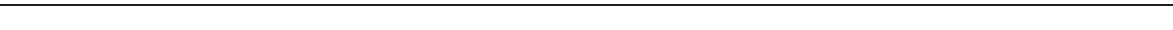
Fig. 5 Vascular alterations after intraocular VEGF-A injection. a Morphology of IB4-stained P6 wild-type retinal vessels at 4 h after administration of human VEGF-A165 (0.5 µ l at a concentration of 5 μ g μ l − 1 ). Note blunt appearance of the vessel front after VEGF-A injection but not for vehicle (PBS) control. Scale bar, 200 µ m. b Quantitation of sprouts and fi lopodia at the front of the P6 vessel plexus after injection of VEGF-A165 or vehicle control. Error bars, s.e.m. p -values, Student ’ s t -test. c PDGFR β + (green) pericytes are unaffected by short-term VEGF-A administration, whereas VEGFR2 immunosignals (white) are increased in IB4+ (red) ECs (arrowheads). Images shown correspond to insets in a . Scale bar, 100 µ m. d Quantitation of VEGFR2 immunosignals intensity in the peripheral plexus of P6 retinas after injection of VEGF-A165 or vehicle control. Error bars, s.e.m. p -values, Student ’ s t -test. e Confocal images showing increased Esm1 immunostaining (white) in IB4+ (red) ECs in the peripheral plexus (arrowheads) after VEGF-A injection in P6 pups. Scale bar, 200 µ m. f VEGF-A165 injection-mediated increase of Esm1 immunosignals (normalized to IB4+ EC area) in the peripheral capillary plexus but not at the edge of the angiogenic front in comparison to PBS-injected controls at P6. Error bars, s.e.m. p -values, Student ’ s t -test. NS, not statistically signi fi cant. g Short-term VEGF-A165 administration leads to clustering of Erg1+ (green) and IB4+ (red) ECs, as indicated, in thick sprout-like structures of P6 retinas. Panels in the center and on the right (scale bar, 20 µ m) show higher magni fi cation of the insets on the left (scale bar, 100 µ m). Dashed lines in panels on the right outline IB4+ vessels. h Quantitation of EC density in the leading front vessel and emerging sprouts of the P6 angiogenic front after injection of VEGF-A165 or vehicle control. Error bars, s.e.m. p -values, Student ’ s t -test